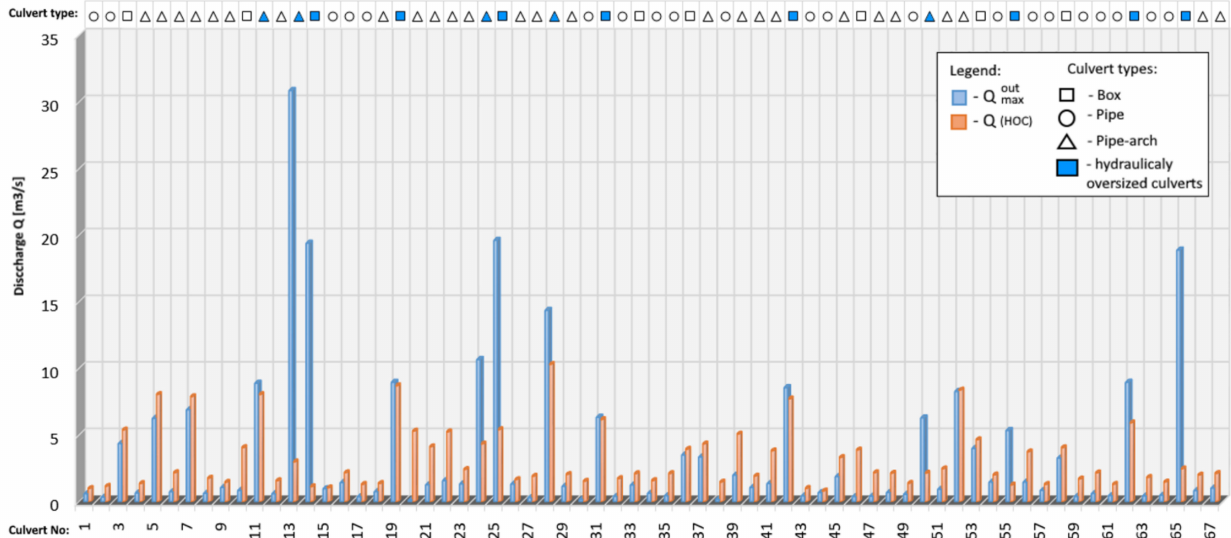
Figure 8. Compared values of maximum culvert capacity Q out max and the flow value according to the CHOC, Q (CHOC), for each culvert on the analyzed road